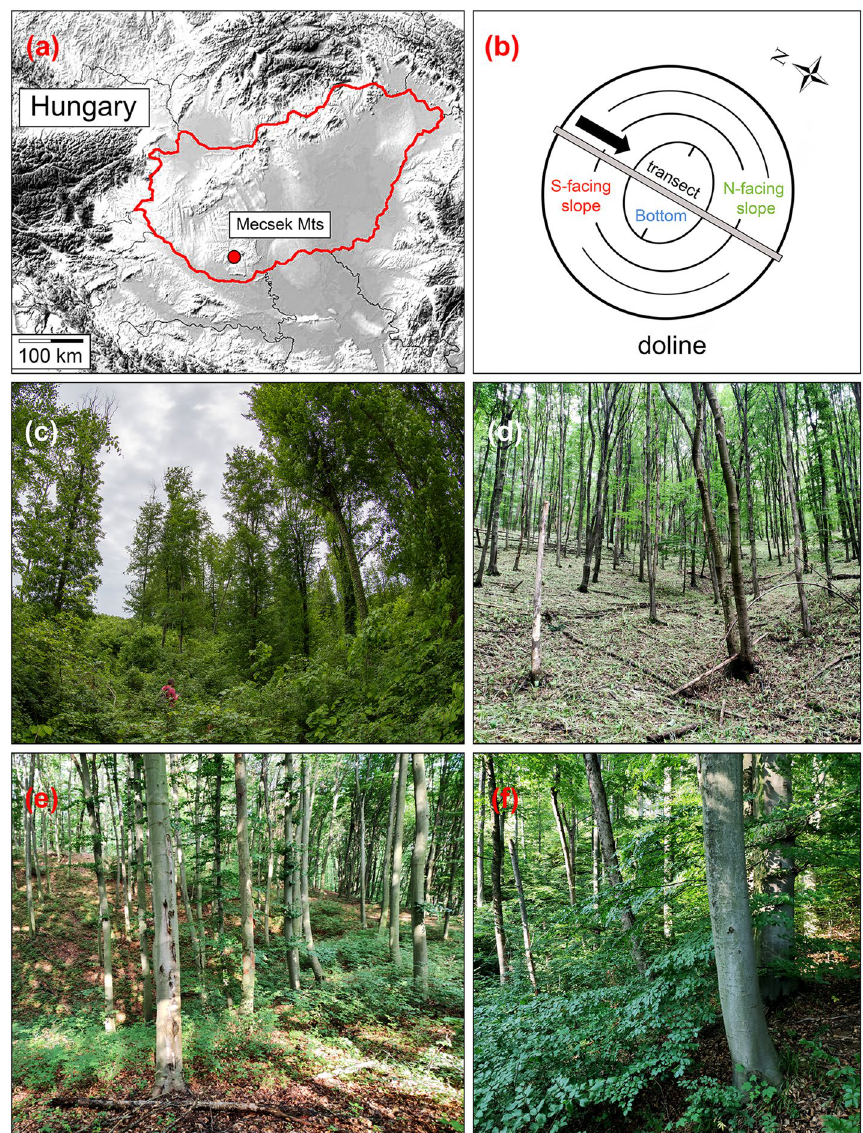
Fig. 1 Study area, sampling design, and dolines. a Location of the study area in Hungary. b Position of transects within dolines. c Doline dominated by 5–10-year-old forests. d Doline covered with 40–45-year-old forests. e Doline covered with 60–65-year-old forests. f Doline covered with more than 90-year-old forests (photos: Gábor Li and Zoltán